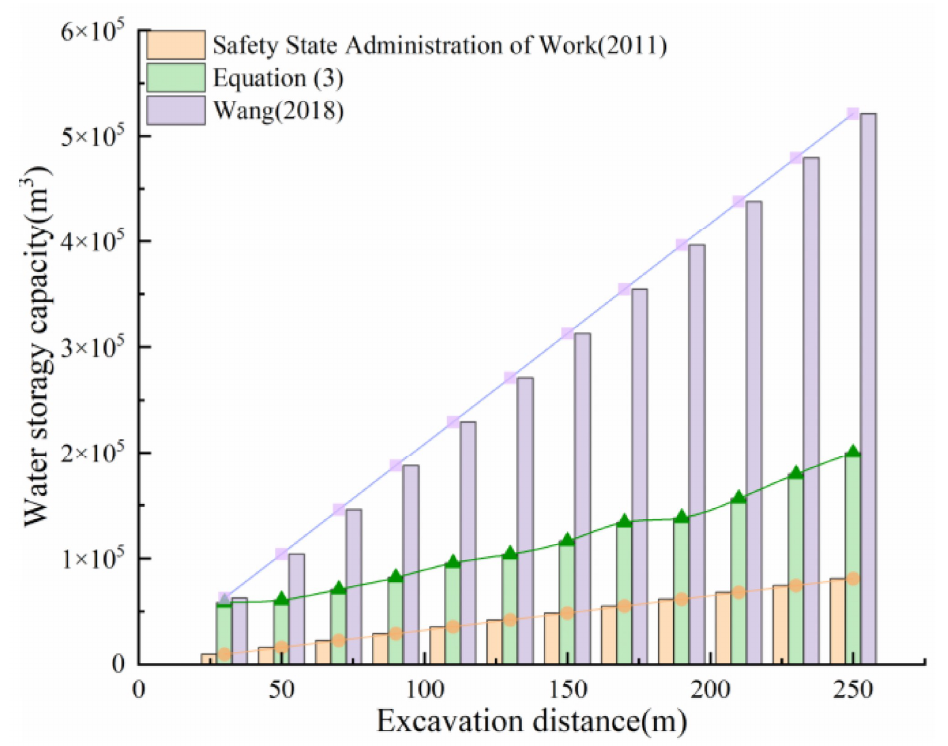
Figure 5. Relationship between excavation distance and water storage capacity